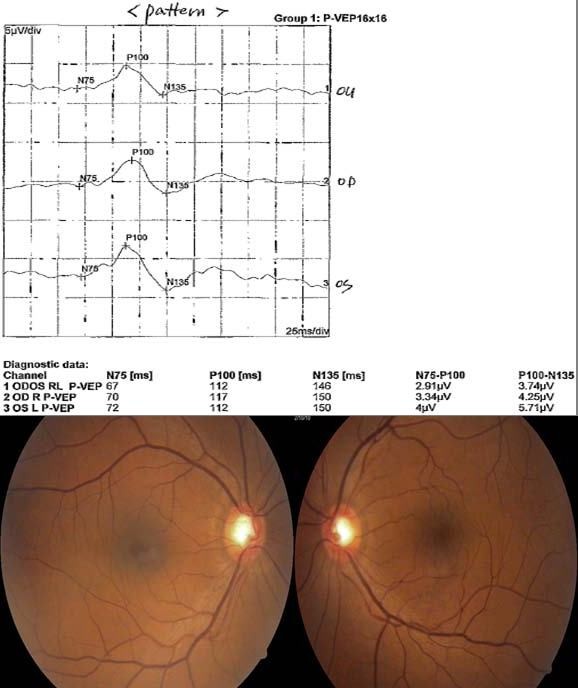
Pattern VEPs and fundi 6 months following skull fracture in a 53-year-old male. Note that the similar amplitude and latency in both eye eyes. Visual acuities were 20/200 right; 20/200 left. The optic cup disc ratio was 0.6 rights and 0.5 left.